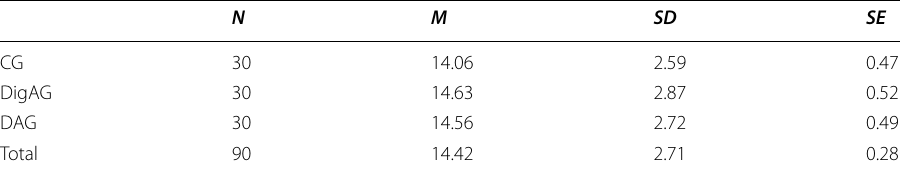
Table 6 Descriptive statistics of speaking accuracy pretest of all groups